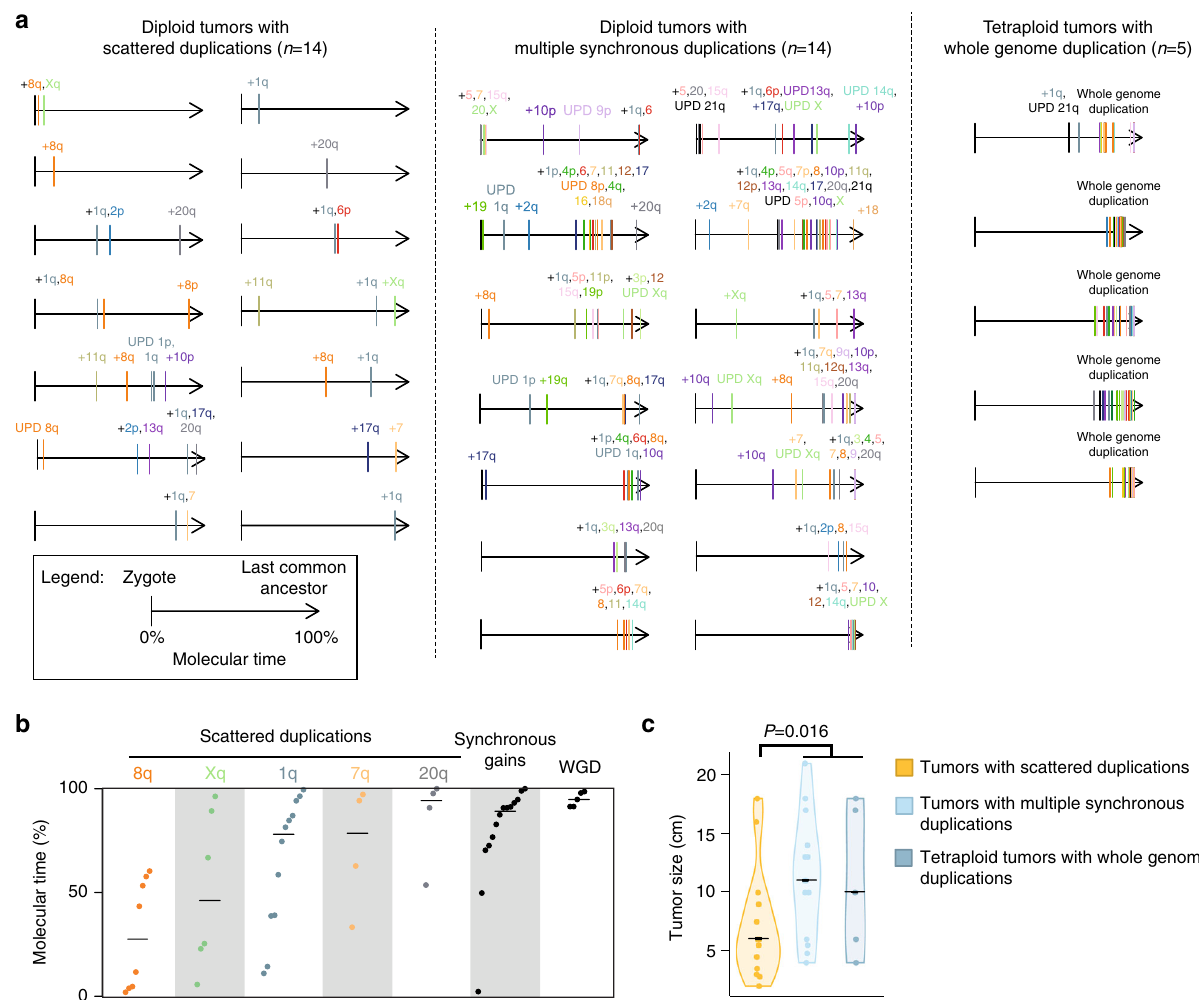
Fig. 6 Chromosome duplications are late events in hepatocellular carcinomas. a Timing of copy-number gains in 33 informative HCC. The timing of chromosome gains was estimated from the ratio of duplicated over non-duplicated mutations. Each arrow represents the point mutation time, 0 being the time when no mutation had been acquired yet and 100 the time when all clonal mutations were present. Chromosome gains are placed on this scale with a color code for each chromosome. Tumors are grouped based on the presence in their history of whole genome duplications or multiple synchronous gains de fi ned as the co-occurrence of ≥ 4 duplications in a window shorter than 30% mutation time. When several copies of a same chromosome were gained, only the fi rst event is represented for clarity. b Distribution of duplication timings in point mutation time for the most recurrent scattered duplications, synchronous gains of ≥ 4 chromosome regions and whole genome duplications. c Tumor size distribution in tumor groups showing different patterns of chromosome duplication acquisition, as de fi ned in